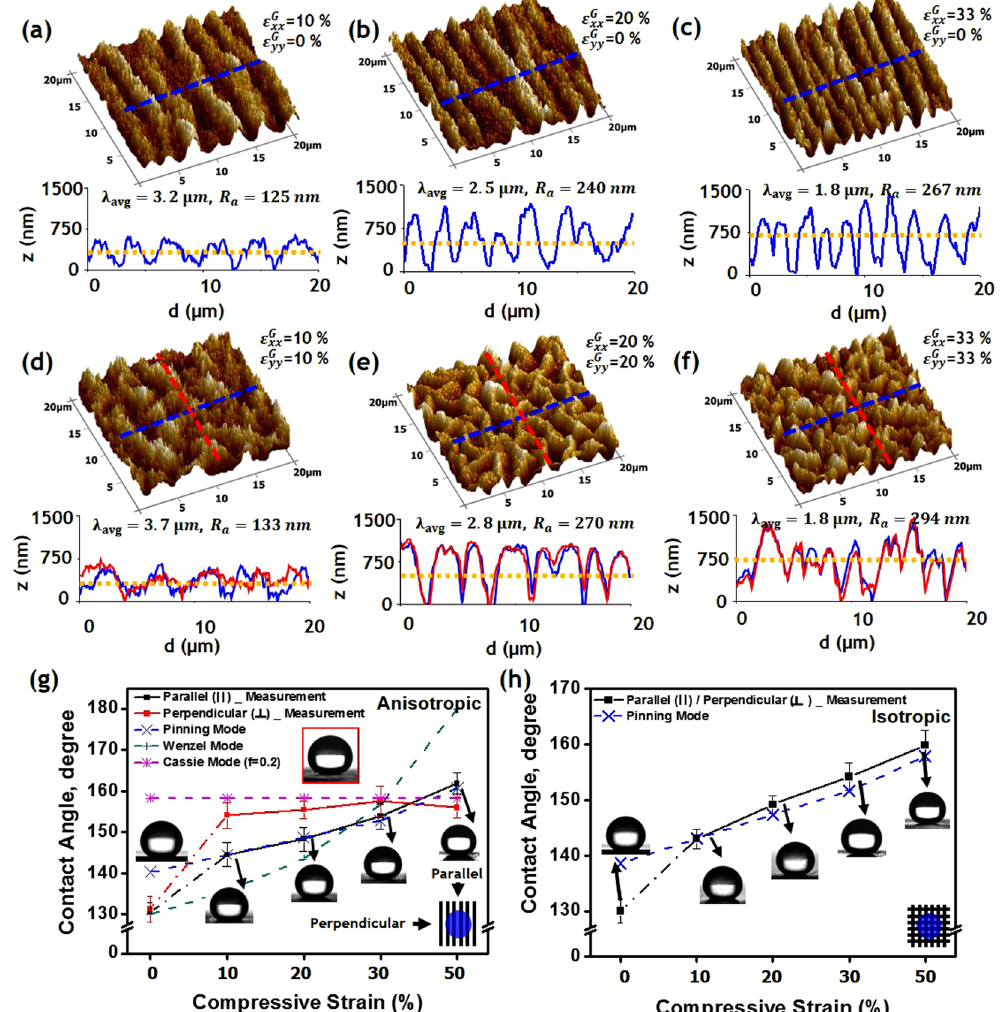
Figure 3. AFM analysis and contact angle of wrinkled pattern with increasing level of surface roughness. The surface morphology shifts from wrinkles having long wavelength and low height ( a ) and ( d ), to a uniformly structured surface with various levels of surface roughness ( b , c ) and ( e , f ). R α indicates the average surface roughness, measured on 20 μ m × 20 μ m regions. On the bottom of each substrate, blue and red lines stand for the profiles of the surface, and the yellow line shows the average amplitude of the wrinkle. ( g , h ) static water contact angle as a function of the compressive strain %. The insets of ( g ) show the anisotropic wettability behavior of the water droplet contact angle along the wrinkle direction; the angle in the parallel direction increases with the strain value, while a stable contact angle is maintained in the perpendicular